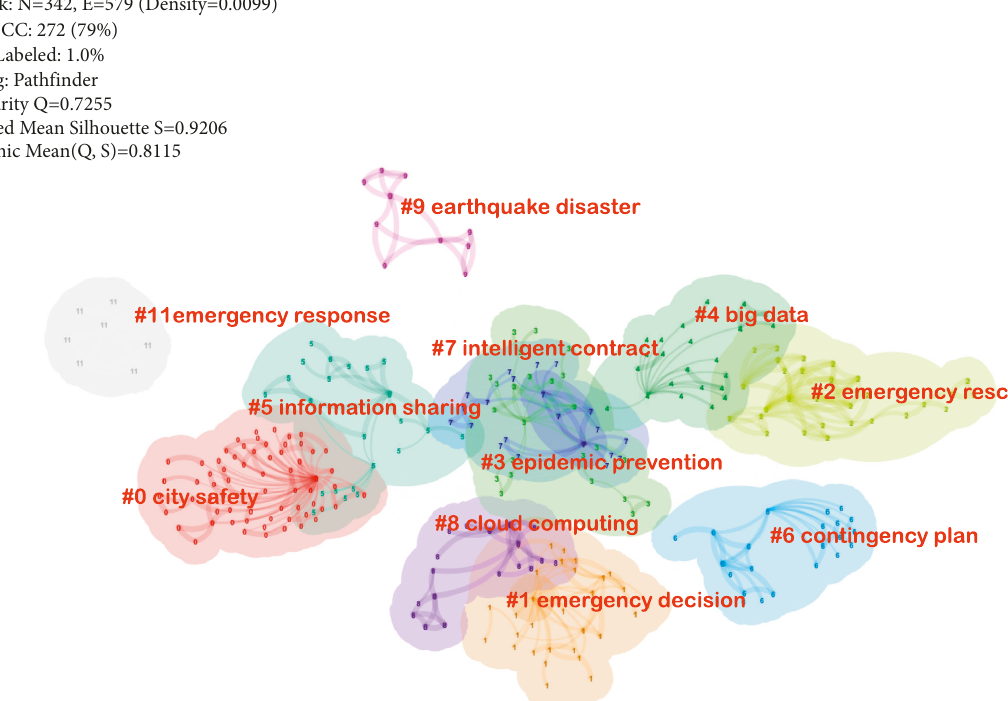
Figure 11: Co-word clustering map of Chinese DEM